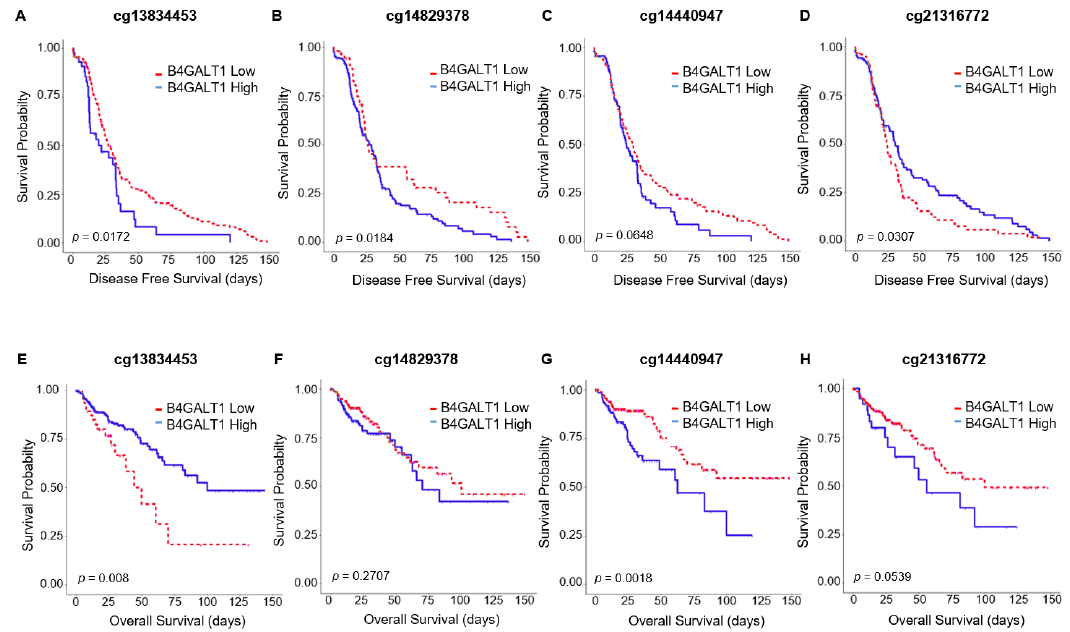
Figure 3. Kaplan–Meier survival curves of high (blue line) and low (red line) methylated B4GALT1 promoter CpGs in TCGA cohort 6 ( n = 300). OS in ( A ) cg13834453, ( B ) cg144440947, ( C ) cg14829378, ( D ) cg21316772; DSF in ( E ) cg13834453, ( F ) cg144440947, ( G ) cg14829378, ( H ) cg21316772.